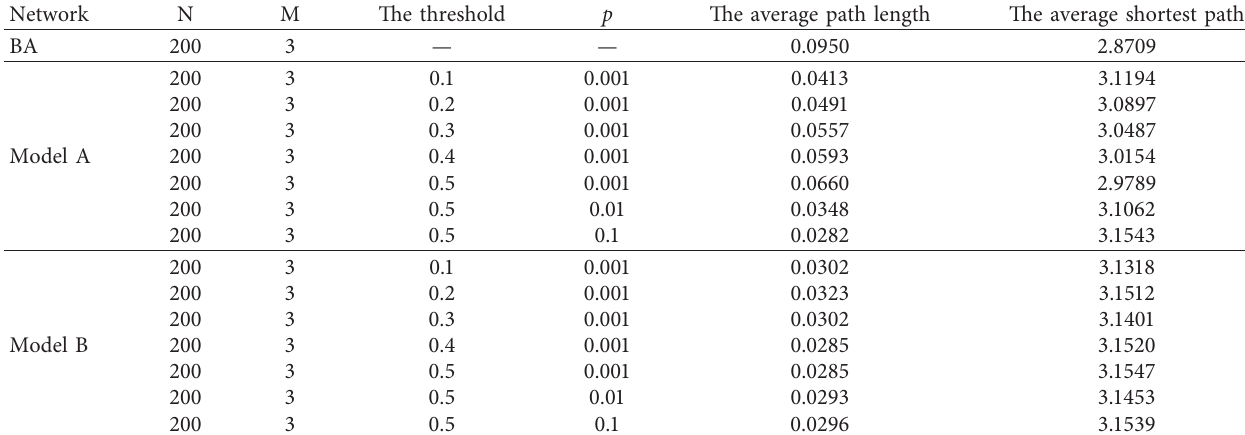
Table 1: Comparison of network